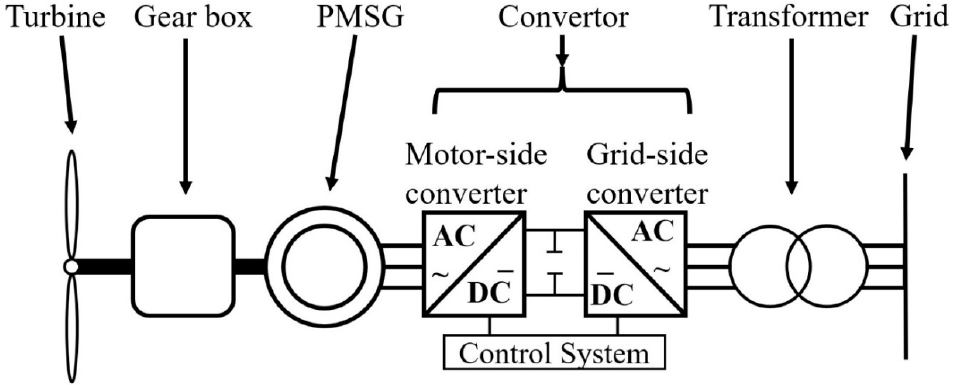
Figure 9. PMSG-based tidal TCG system.